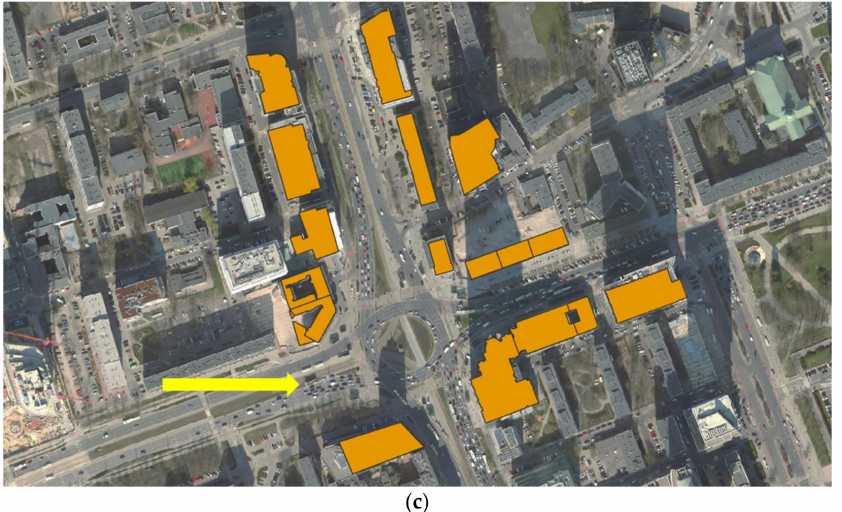
Figure 3. The location of the Rondo ONZ 04 tram stop. ( a ) Visualization of the location of the Rondo ONZ 04 tram stop (source: Google Maps, 2021). ( b ) The surroundings of the Rondo ONZ 04 tram stop, view from the northwest (source: Google Earth 2021). ( c ) Visualization of the outlines of buildings (orange) in the vicinity of the Rondo ONZ 04 tram stop (data sources: BDOT10k and orthophotomap (WMS) provided by PZGiK).